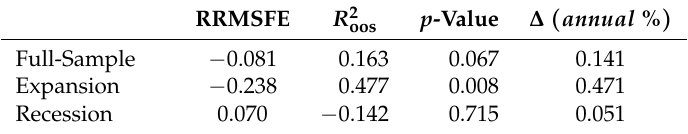
Table 4. Performance evaluation for an Investor with Mean Variance Utility,